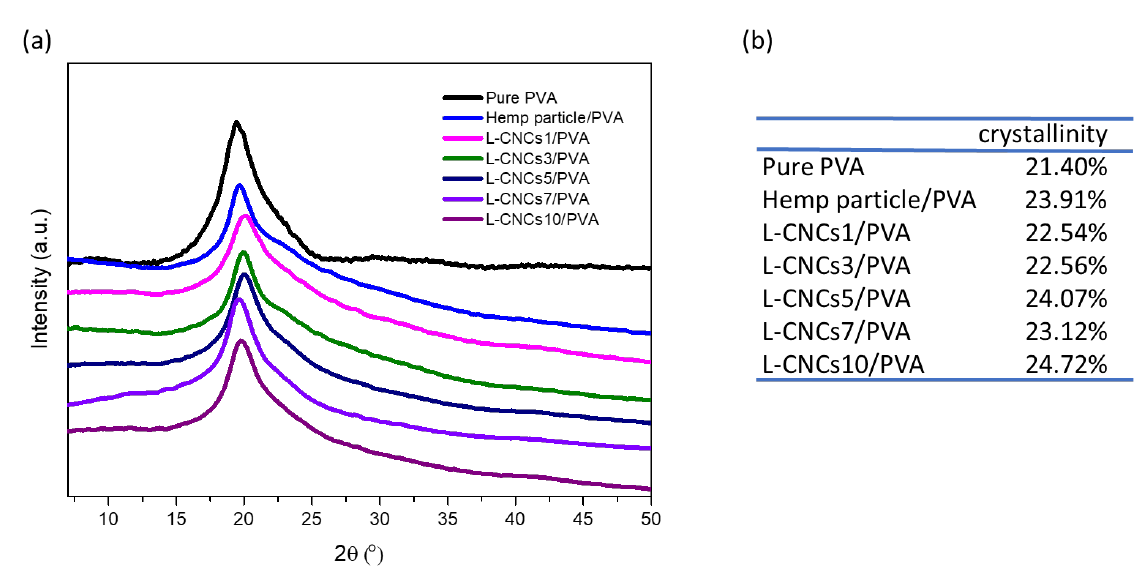
Figure 9. ( a ) XRD spectra and ( b ) crystallinity of pure PVA, hemp particle/PVA and L-CNCs/PVA films (5 wt. %).